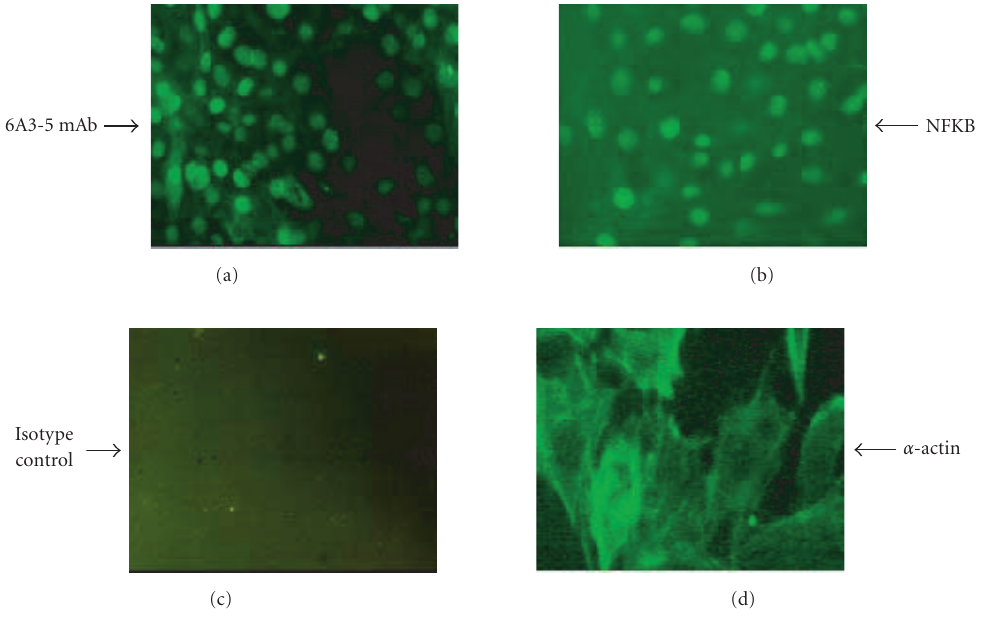
Figure 3: 6A3-5/Osa2 cellular localization on VSMC . Actin was used as a cytoplasmic control of smooth muscle cells marker, while NFKB served as a nuclear control. Cell nucleus was labelled with an anti-6A3-5/Osa2 or an anti-NFKB antibody in comparison to isotype control (mouse IgG).